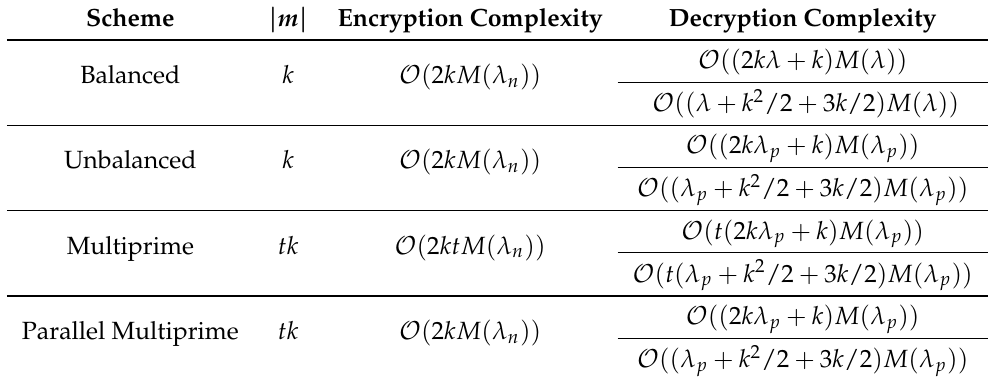
Table 5. Performance analysis.